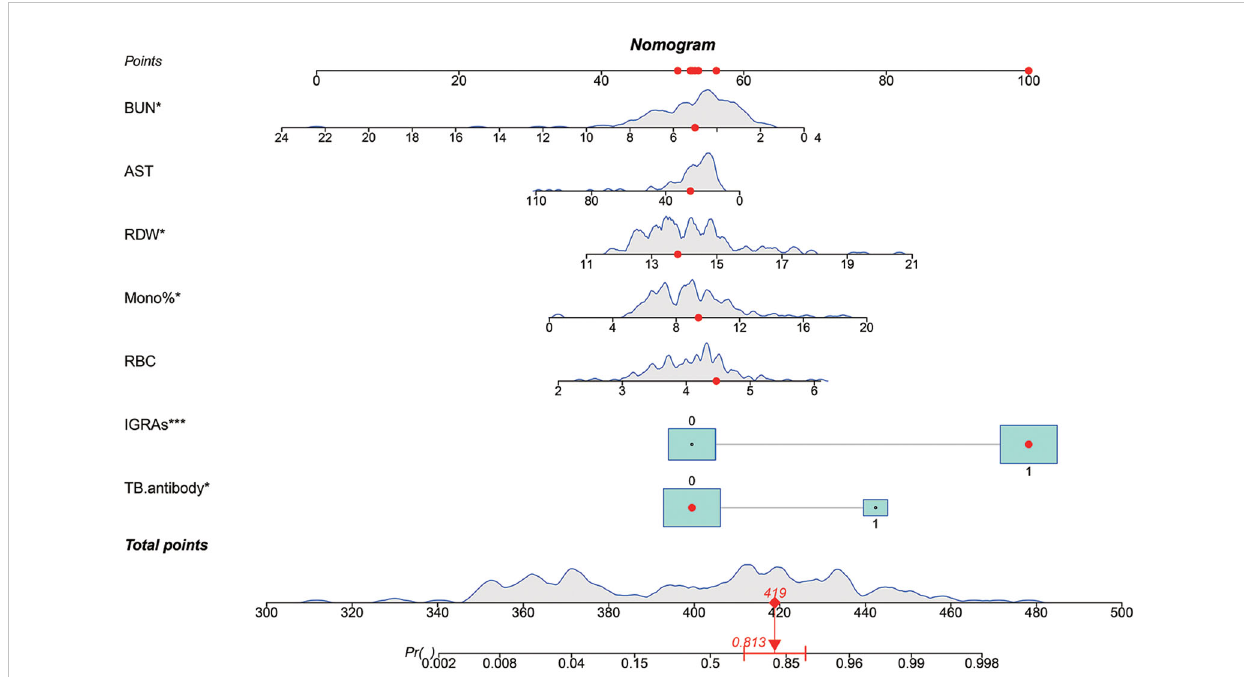
FIGURE 3 A predictive nomogram model for the early diagnosis of spinal tuberculosis. The red dots in the fi gure demonstrate the usage of the nomogram. A patient ’ s information was projected on the nomogram, and this patient had a fi nal score of 419, corresponding to a probability of 0.813 (>0.5), so we judged this patient to have a fi nal diagnosis of spinal tuberculosis (STB). The patient ’ s fi nal diagnosis was consistent with our